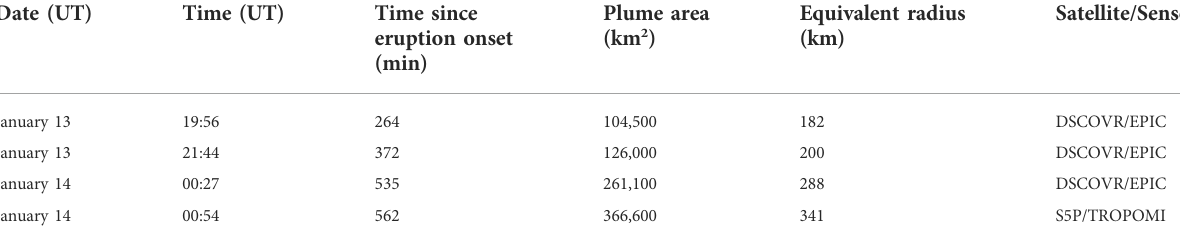
TABLE 3 Growth of the 13 January 2022 HTHH volcanic SO 2 cloud observed by DSCOVR/EPIC and TROPOMI.